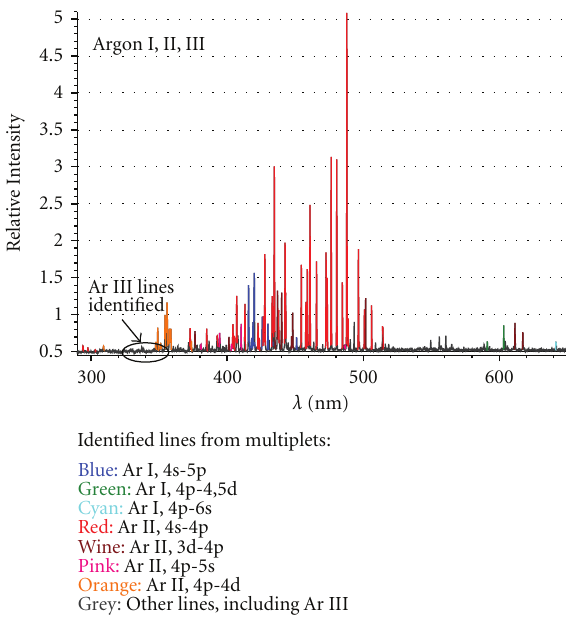
Figure 20: A typical HT Ar spectrum in the 290 to 650 nm wavelength region. Main lines of Ar I and Ar II have been identified separately for each multiplet and marked with di ff erent